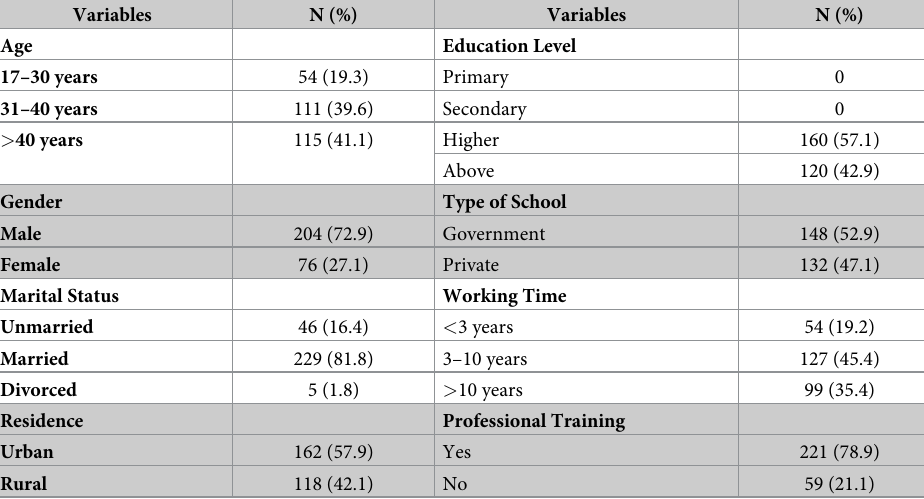
Table 1. Demographic characteristics of participants.